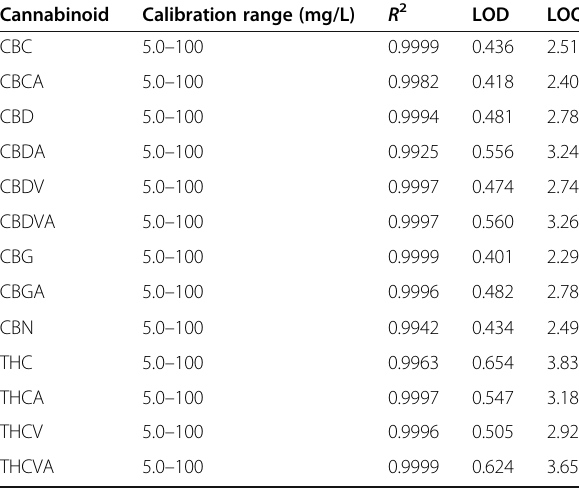
Table 1 Cannabinoid analysis by HPLC: calibration curves, limits of detection, and limits of quantification Cannabinoid Calibration range